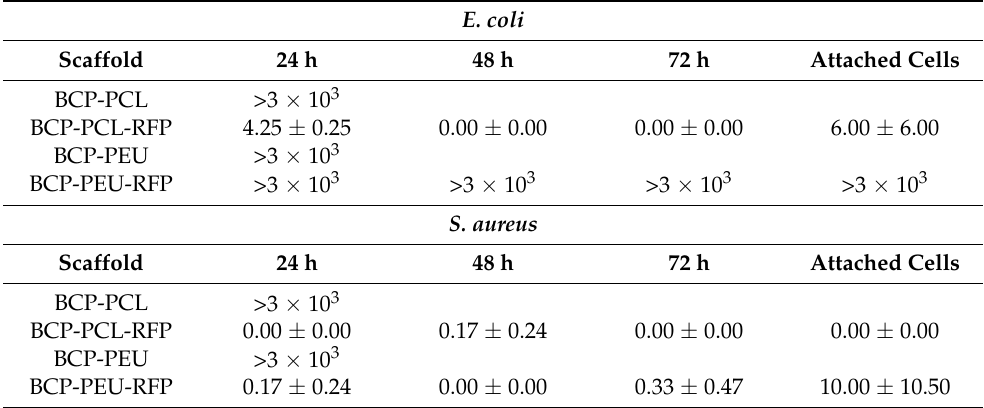
Table 2. Antibacterial activity of the different scaffolds. The antibacterial activity was determined by following the number of viable cells as CFU ml − 1 .